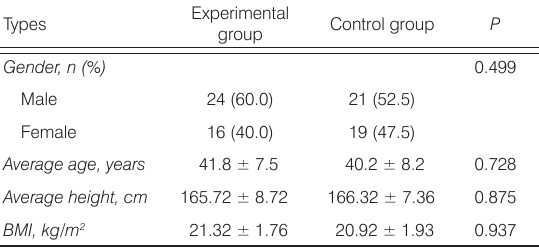
Table 1. Comparison of general information between the two groups ( n =